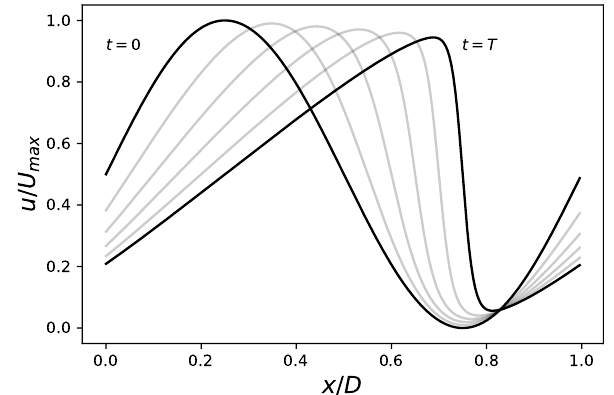
Figure 1. Nonlinear solution of the diffusive Burgers equation for the times t = { 0 , 0 . 2 , 0 . 4 , 0 . 6 , 0 . 8 , 1 } T . distance between the two geographical positions x and y